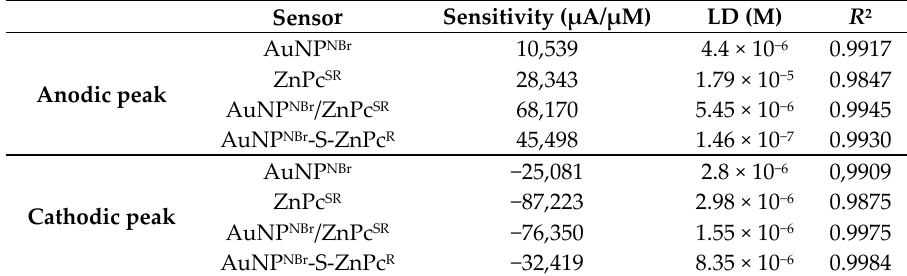
Table 1. Sensitivity, LDs and regression coefficients calculated form the calibration